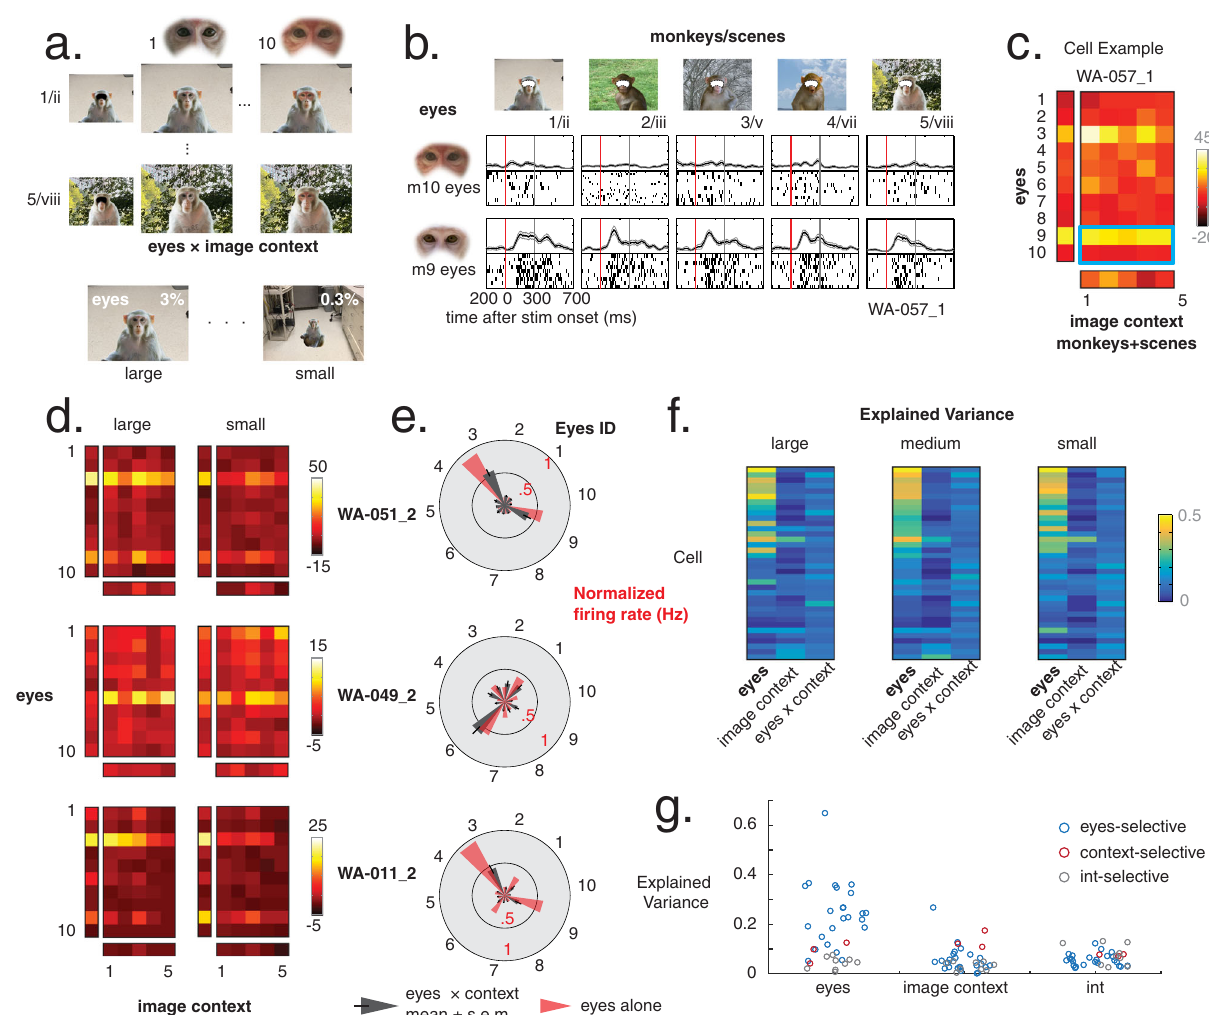
Fig.5|Eye×ImageContextswappingcon fi rmsdominanceoflocalparttuning. a Recombination paradigm for eyes×image context stimuli. From full monkey× scene images, eyes from monkeys 1 to 10 are excised and exchanged with two full image contexts. Images are presented at the same three sizes as in the original experiment. b Rasterplotsforoneeyes-selectiveAMcell,WA057_1(sameasFig.2a, b). Responses to eyes from monkeys 9 to 10 exchanged with fi ve whole image contexts.Eyesfromm9drivetheresponse,withlittleinputfromthelargercontext. Macaque images in a – b were obtained from https:// fi gshare.com/articles/dataset/ Macaque_Faces/9862586/1 under a CC-BY 4.0 license . c Heatmap of average WA 057_1 responses to all large eyes×image context stimuli; tuned to eyes with low contribution from image context (two-way ANOVA, explained variance due to